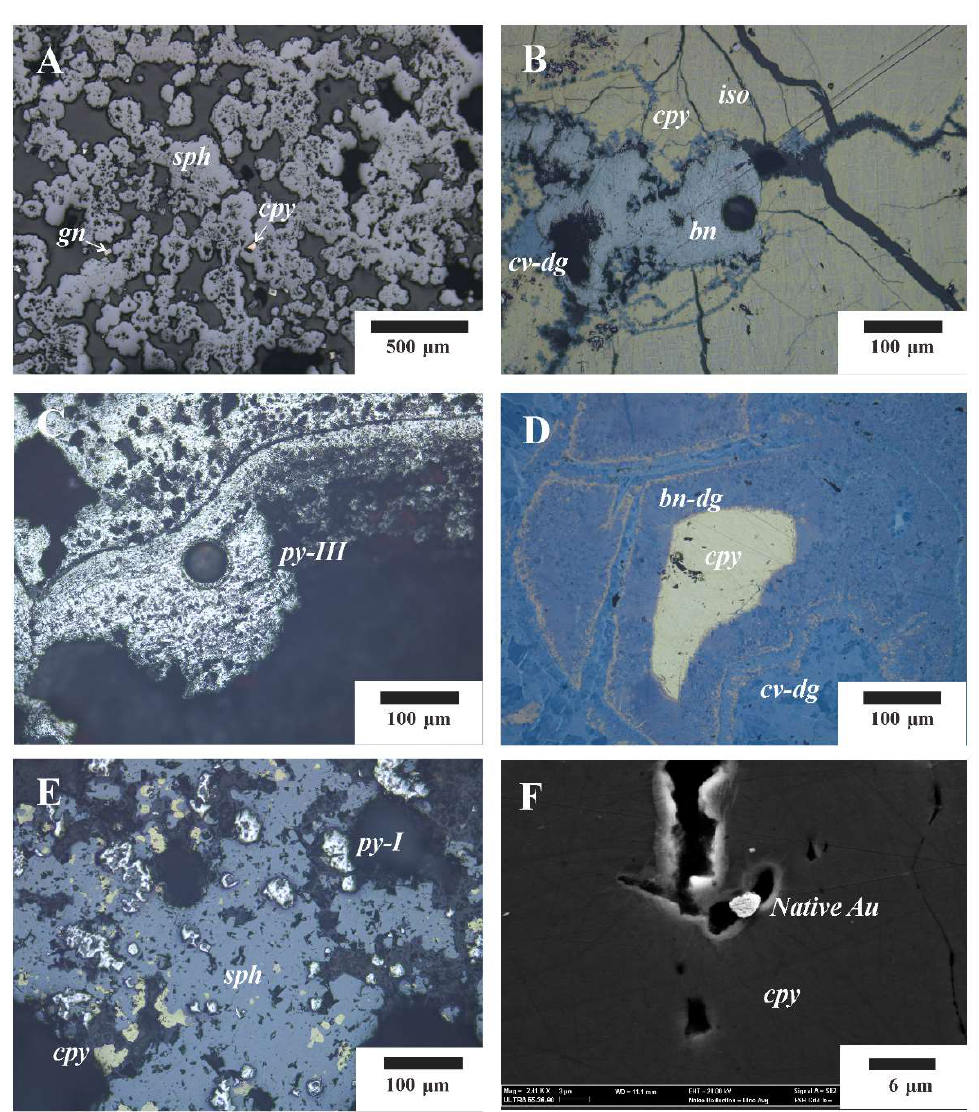
Figure 2. Optical and SEM photomicrographs of typical mineral assemblages. ( A ) colloform sphalerite and galena grains in the Zn-rich chimney sulfides (sample 17A-TVG9); ( B ) massive chalcopyrite intensely intergrown with isocubanite and surrounded by bornite and covellite–digenite intergrowths (sample 17A-TVG7-1D); ( C ) colloform pyrite in outlier of the Zn-rich chimney sulfides (sample 17A-TVG9); ( D ) bornite–digenite and covellite–digenite intergrowth surrounding chalcopyrite (sample 19III-TVG6); ( E ) massive sphalerite and co-genetic chalcopyrite and euhedral pyrite (sample 17A-TVG9); ( F ) native gold particles associated with chalcopyrite (sample 17A-TVG7-1D). Abbreviations: bn–dg = bornite–digenite intergrowths, cpy = chalcopyrite, cv–dg = covellite–digenite intergrowths, py = pyrite, sph =